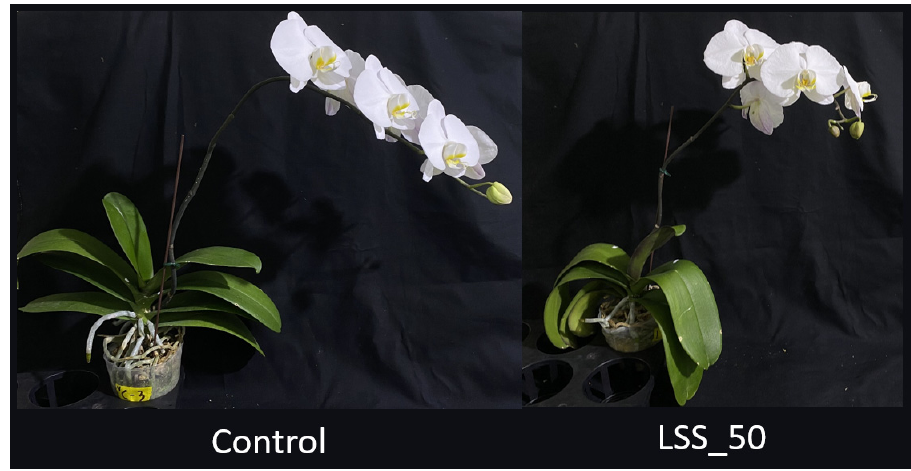
Figure 11. Subsequent flowering quality of Phalaenopsis Sogo Yukidian ‘V3’ of the control and simulated light shipping for 50 days (LSS_50) at 130 days after simulated shipping.